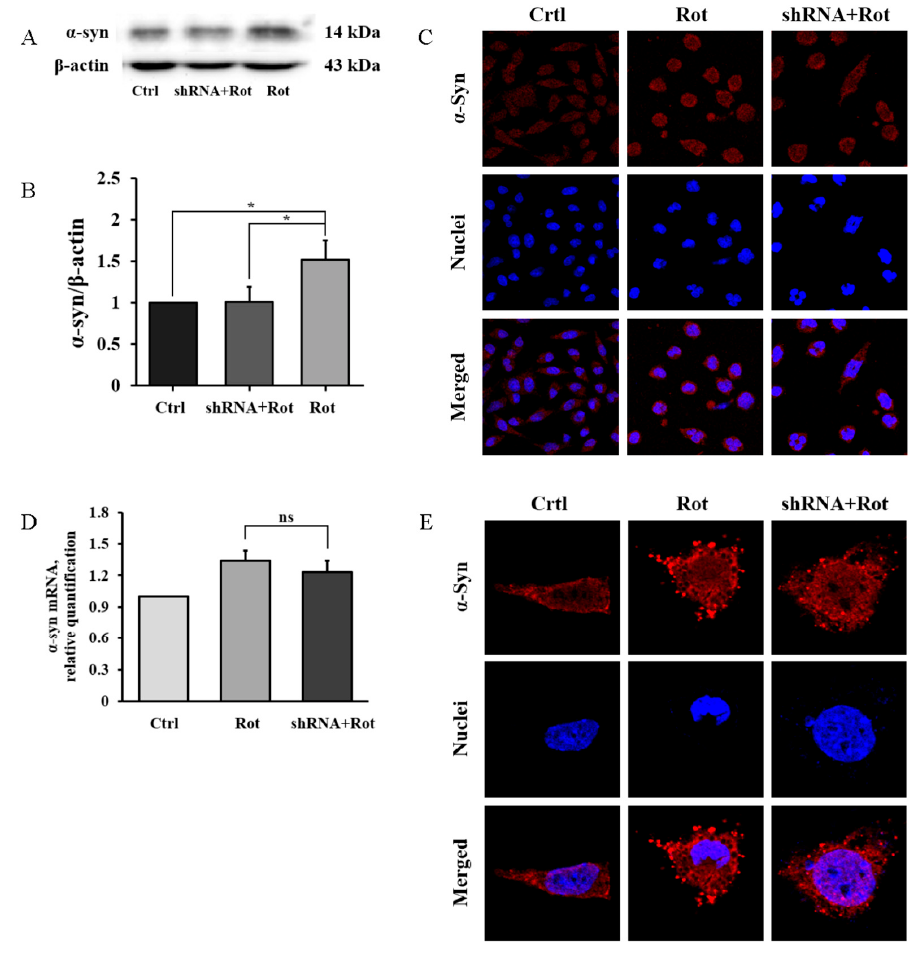
Figure 5. Knockdown of HDAC4 reversed the rotenone-induced increase in α -syn levels in SH-SY5Y cells. SH-SY5Y cells transfected with HDAC4 shRNA or control shRNA were exposed to 1 µM of rotenone or vehicle for 48 h. α -Syn levels were detected through Western blot analysis and immunofluorescent staining. mRNA levels of α -syn were determined through qRT-PCR. ( A – C ) Rotenone increased monomeric α -syn levels in SH-SY5Y cells, and the knockdown of HDAC4 reversed the increase in α -syn levels. ( D ) Knockdown of HDAC4 had no significant effect on α -syn gene transcription. ( E ) Rotenone induced aggregation of α -syn in SH-SY5Y cells, which was rescued through the knockdown of HDAC4. * p < 0.05. Ctrl., control. Rot., rotenone. ns., non-signi fi cant.